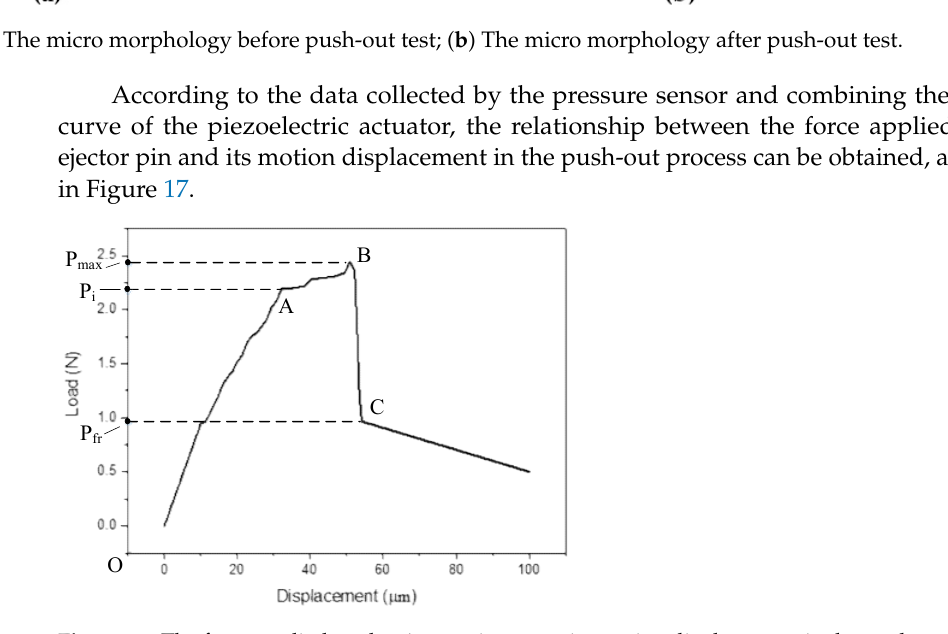
Figure 17. The force applied on the ejector pin versus its motion displacement in the push-out pro- cess.